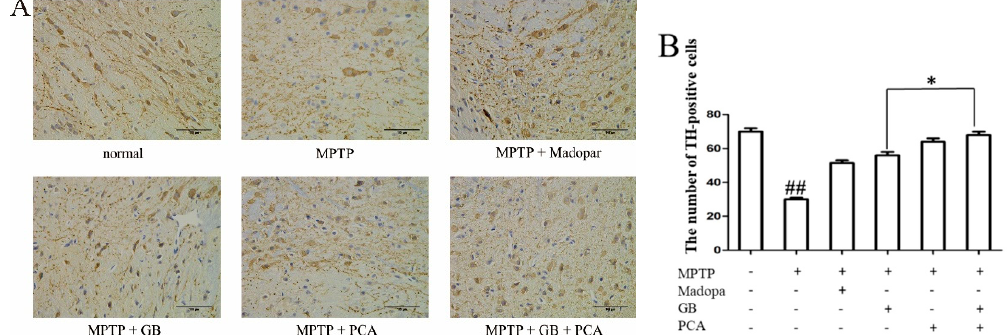
Figure 7. Combined effects of GB and PCA on TH expression in substantia nigra of Parkinson ′ s mice induced by MPTP (400 × ). ( A ) TH expression in substantia nigra. ( B ) Statistics of TH positive cells. disease mice induced by MPTP (400×). ( A ) TH expression in substantia nigra. ( B ) Statistics of TH ## p < 0.01 vs. normal group. * p < 0.05 vs. GB-treated positive cells. ## p < 0.01 vs. normal group. * p < 0.05 vs. GB-treated group.